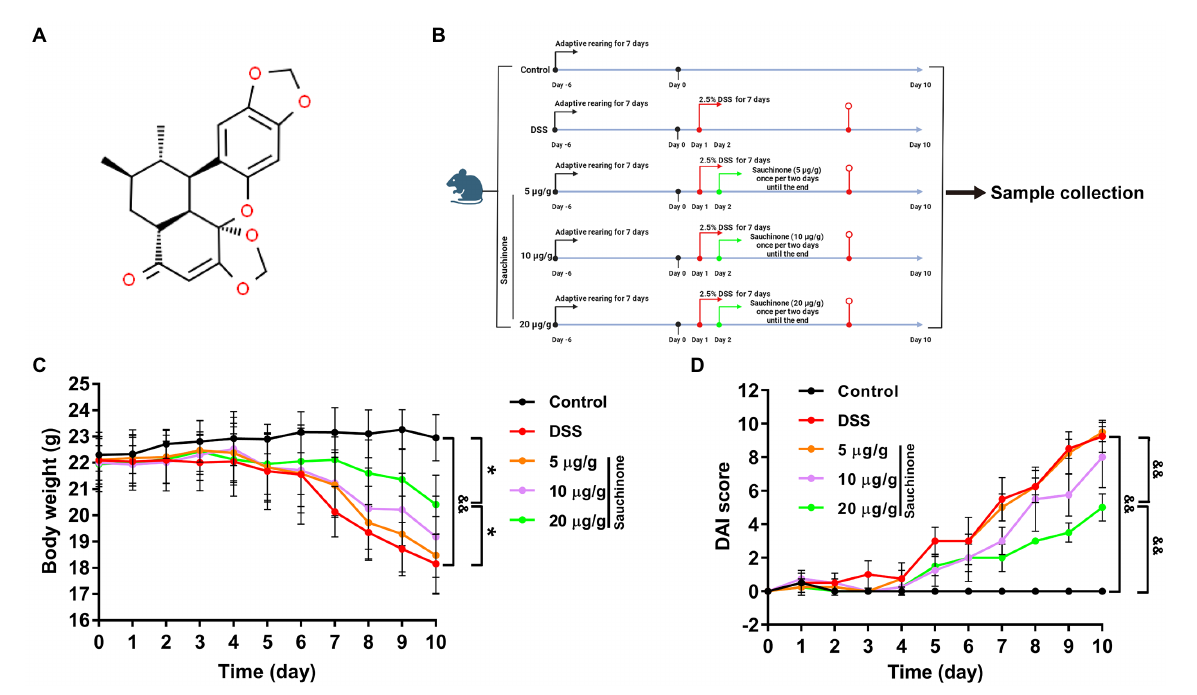
FIGURE 1 Effects of sauchinone on the pathological symptoms of dextran sulfate sodium (DSS)-induced UC mice. (A) The structural formula of sauchinone. (B) Schematic representation of the experimental design using the DSS-induced UC mice model and sauchinone treatment. (C) Body weight was measured. (D) Disease activity index (DAI) score was calculated. Data are expressed as mean ± standard deviation. * p < 0.05 and && p < 0.01 vs. corresponding control; n =